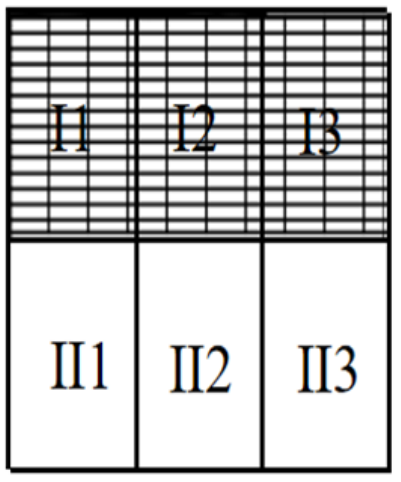
Figure 1. Division diagram of pen area for behavior observation.